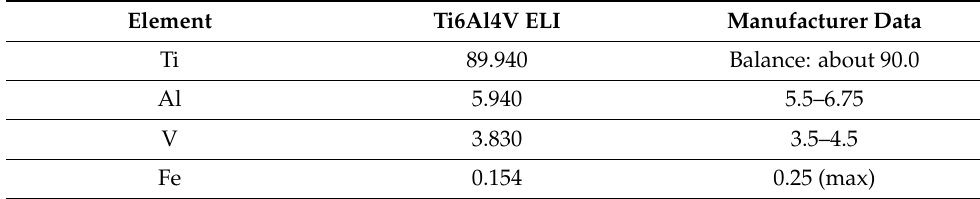
Table 1. Chemical analysis (%) of Ti6Al4V alloy.